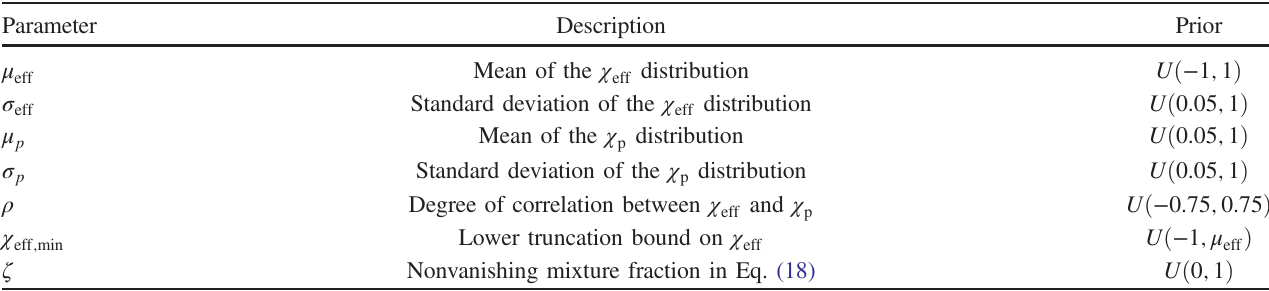
TABLE XIII. Summary of G AUSSIAN spin parameters. The χ we discuss